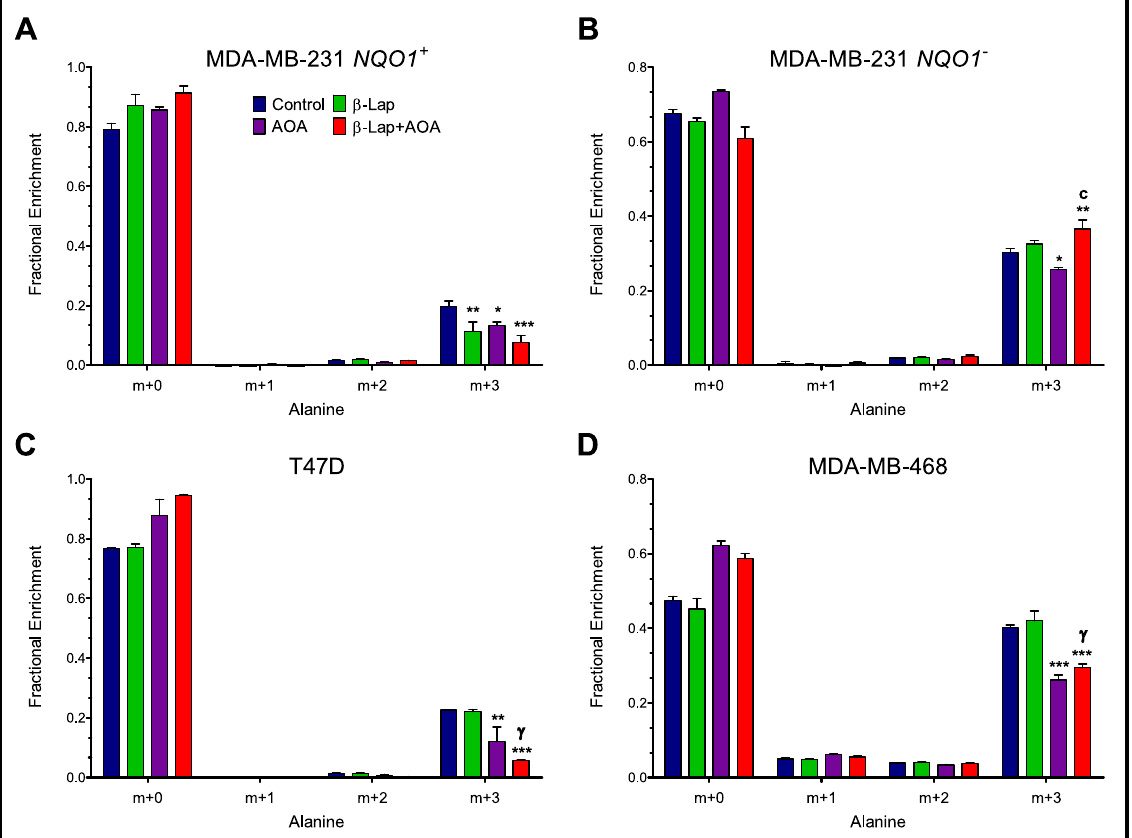
Figure 4. Intracellular alanine isotopologue distribution in MDA-MB-231 NQO1 + (Panel ( A )), MDA- MB-231 NQO1 − (Panel ( B )), T47D (Panel ( C )), and MDA-MB-468 (Panel ( D )). Alanine MID reflects treatment effects on a branching pathway of glycolysis. (Note: n = 3, biological replicate data are represented as mean ± SEM. Statistical significance was determined by ANOVA and student’s t -test post hoc analysis and is presented as: (*) if p ≤ 0.05, (**) if p ≤ 0.01, and (***) if p ≤ 0.001 compared to control. (γ) if p ≤ 0.001 compared to β -lap treatment. (c) if p ≤ 0.001 compared to AOA treatment.)